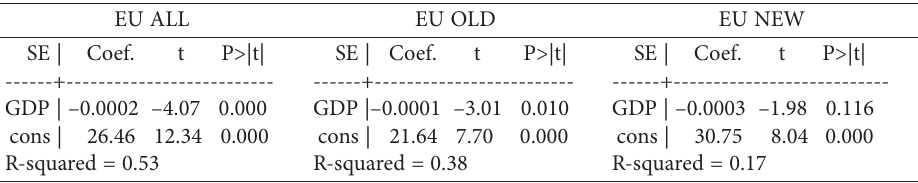
Table 10. Linear regression between SE and GDP EU ALL EU OLD EU NEW SE |